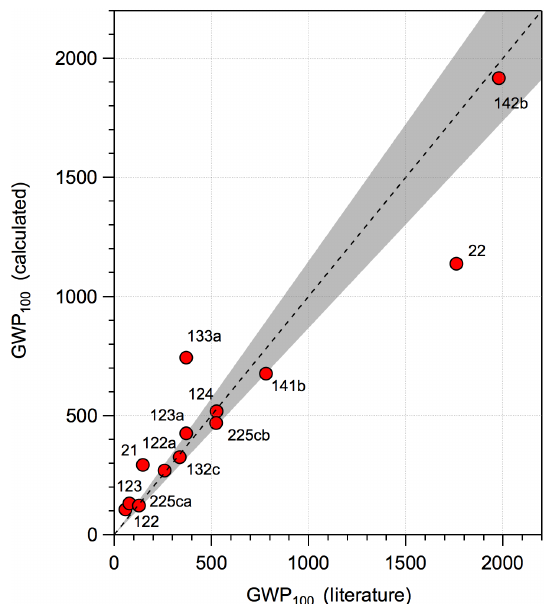
Figure 6. Comparison of 100-year time horizon GWP values re- ported in the WMO assessment (WMO, 2014) and McGillen et al. (2015) for 133a (with lifetime-adjustment and stratospheric tem- perature correction applied) and the values calculated in this study. The dashed line represents the 1 : 1 correlation and the shaded area is a 15% spread around the 1 : 1